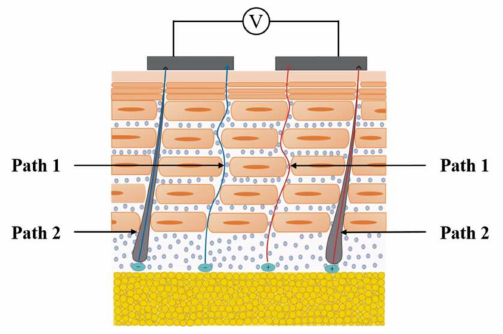
Figure 2. Schematic of the two transport paths for ions in dermis. Path 1 represents ions moving along the dermis–viable epidermis–SC through the intercellular lipid bilayer path; path 2 represents ion transport directly through the sweat glands to the skin